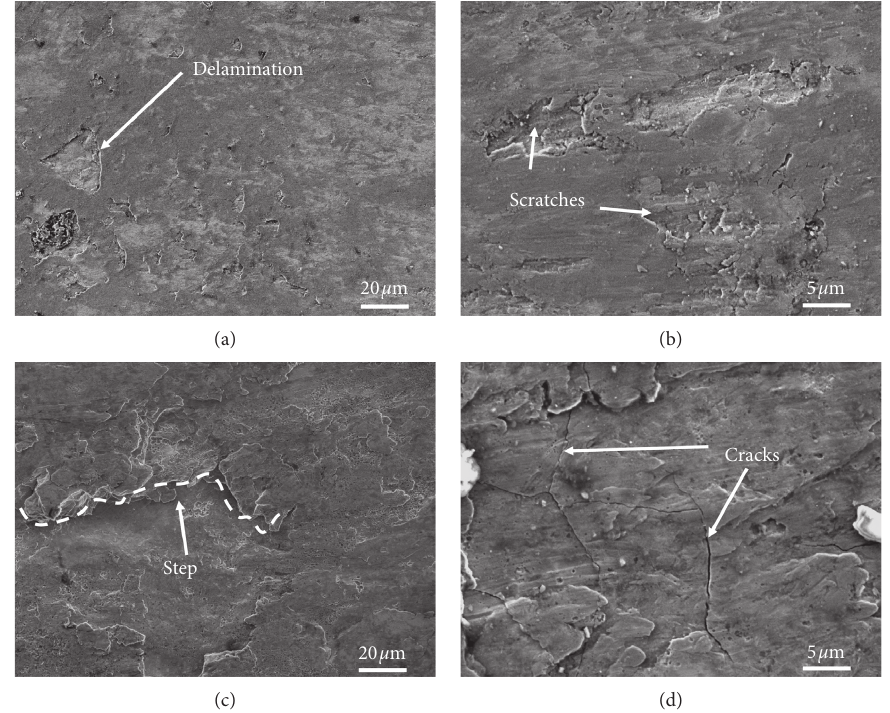
Figure 12: SEM images of the surfaces of Inconel 625 worn by Si images corresponding to (a) and (c),